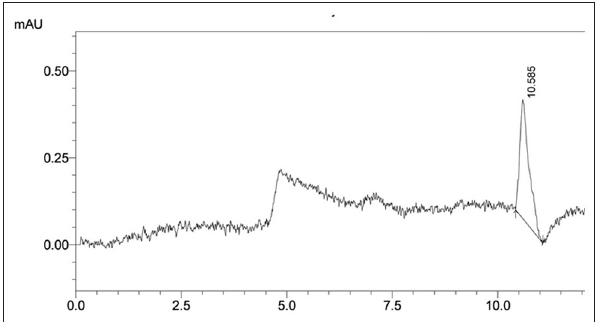
Figure-1: Chromatogram of 0.25 µg/mL aflatoxin B standard retention time of 10.858 min in the mobile phase (63:26:11 H O:methanol:acetonitrile, pH 6.8) at 354 nm, 2 with a LiChrospher ® 100 RP-18 reverse-phase ODS C18 column.